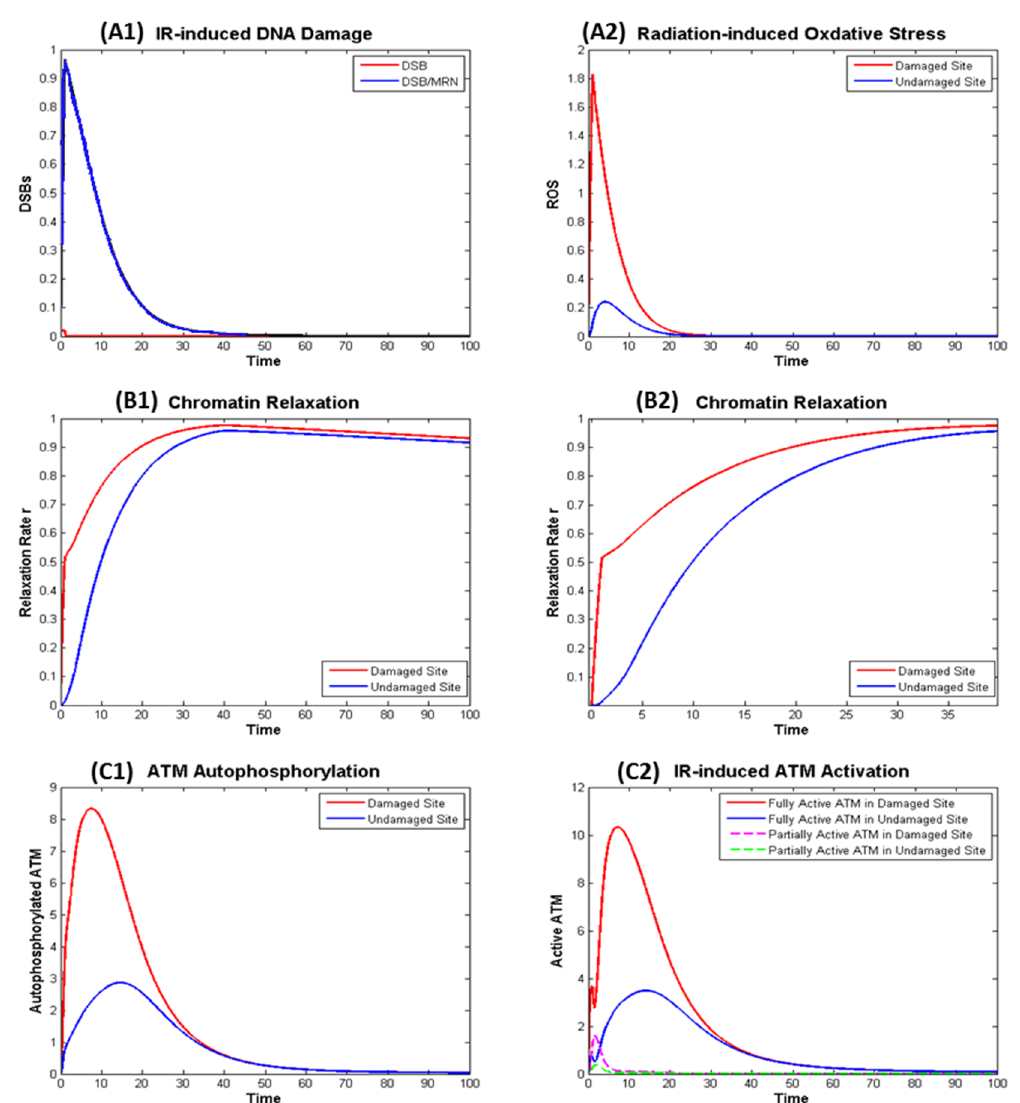
Figure 4. Numerical simulation of the dynamics in the ionizing radiation (IR) induced ATM Activation in the Damaged and Undamaged Sites. ( A ) Effect of radiation: ( A1 ) direct effect—DNA Damage; ( A2 ) indirect effect—Oxidative Stress; ( B ) IR induced chromatin: ( B1 ) kinetics of chromatin relaxation within t = 100; ( B2 ) kinetics within t = 40 in which rapid relaxation within around t = 1 can be observed. ( C ) IR induced ATM autophosphorylation ( C1 ) and (partial and full) ATM activation ( C2